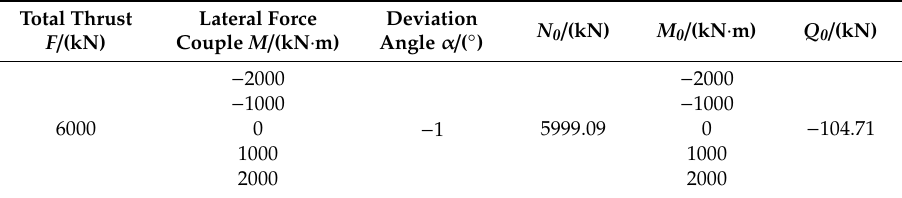
Table 3. The initial parameters under di ff erent jack thrust misalignments.